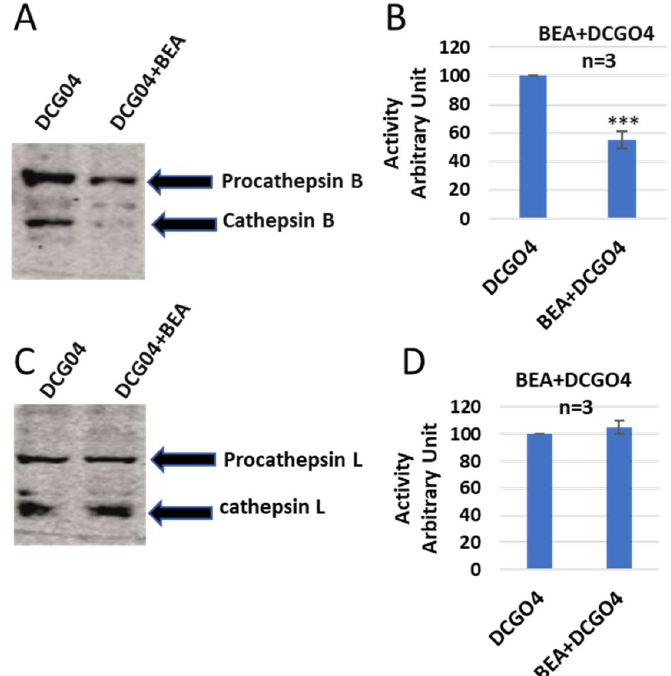
Figure 6. Avidin pull-down experiment of cysteine cathepsins before and after BEA treatment ( A ) Avidin pull-down experiment was performed as described in materials and methods. Conjugated proteins to avidin Sepharose beads were subjected to protein electrophoresis and Western blotting with antibodies specific to human cathepsin B. ( B ) Ratio of cellular contents of cathepsin B before and after treatment with BEA. ( C ) The protein samples were subjected to immunoblotting with anti- human cathepsin L antibodies. ( D ) Ratio of cellular contents of cathepsin L before and after treatment with BEA. The data were analyzed by t -test and statistics using GraphPad Prism. *** p < 0.001. Graphs are shown as mean ± SE, N = 7.